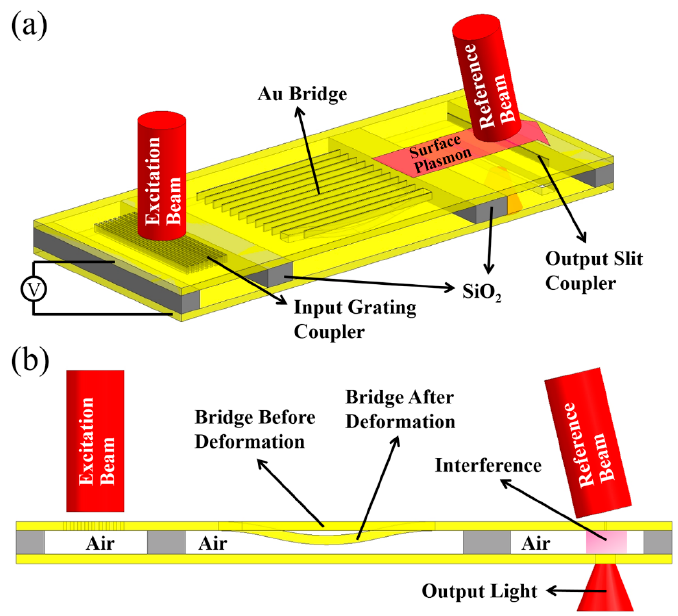
Figure 12. ( a ) 3D view and ( b ) cross-sectional view showing the schematic of the plasmonic phase modulator.